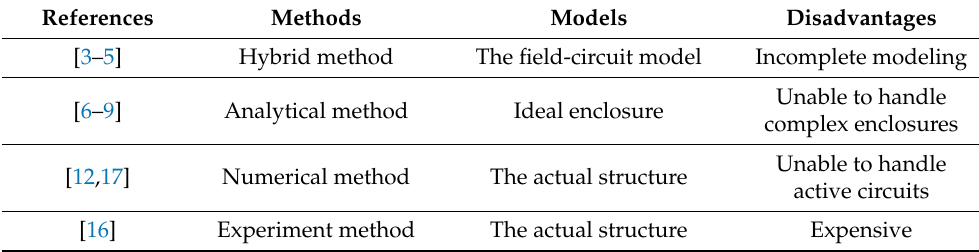
Table 1. The comparison of recently reported research